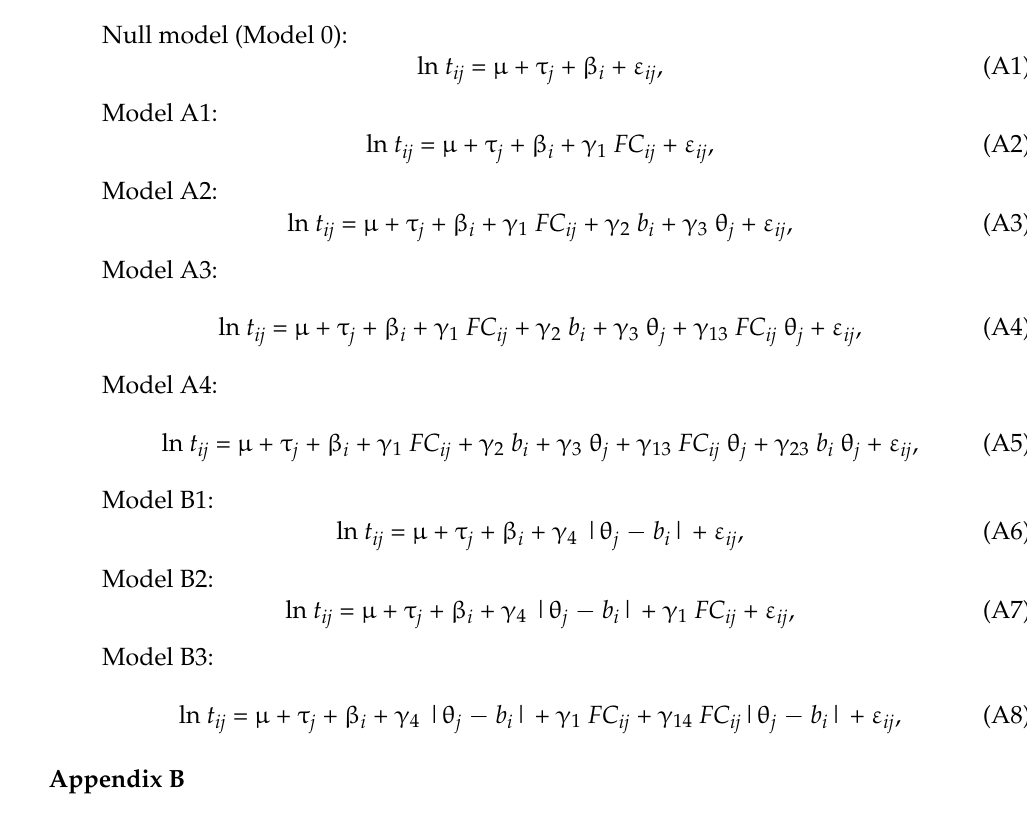
Table A1. Item descriptive statistics and quasi-Rasch model